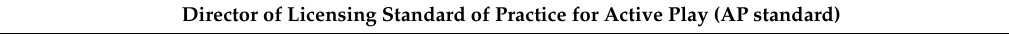
Table A1. Eight standards of practice for active play in BC childcare